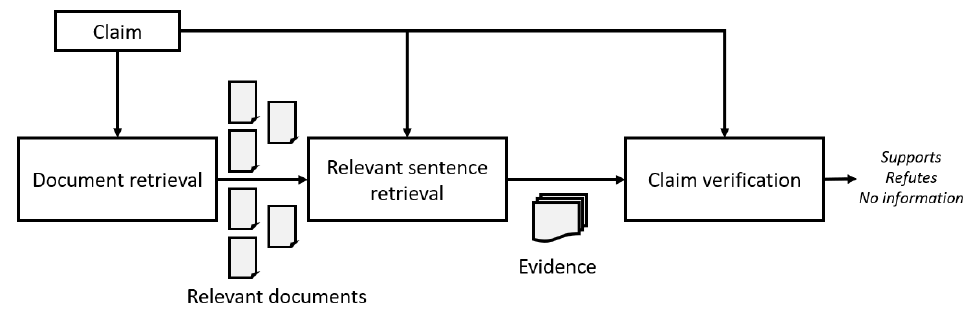
Figure 1. Fact verification usually is composed of three sequential